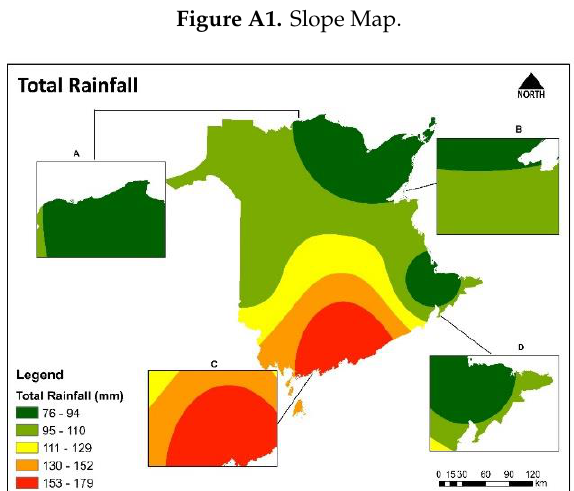
Figure A1 . Slope Map. Figure A1. Slope Map.